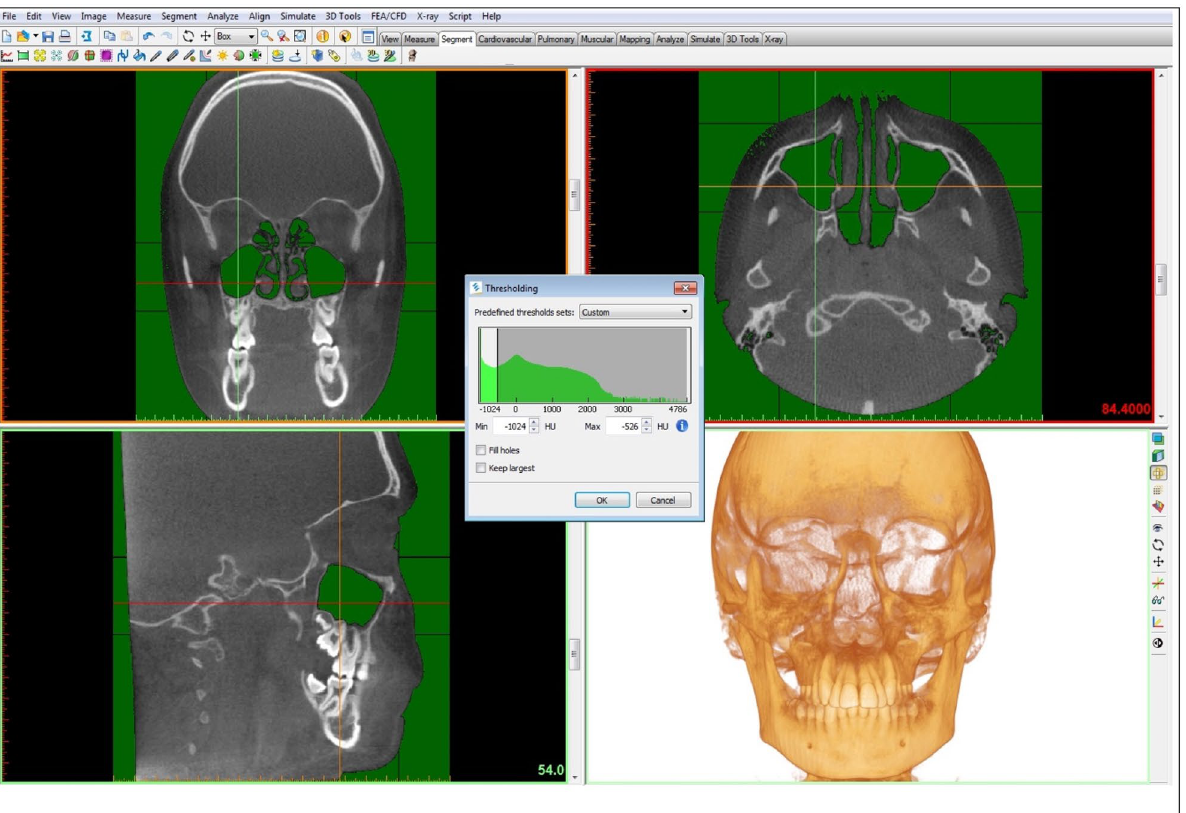
Figure 1. Thresholding function of the Mimics Research™ v.16 software (NV, Technologielaan 15, 3001 Leuven, Belgium, https:// www. mater ialise. com/ en/ medic al/ mimics- innov ation- suite/ mimics) was used to segment each MS: from − 1024 HU (minimum) to − 526